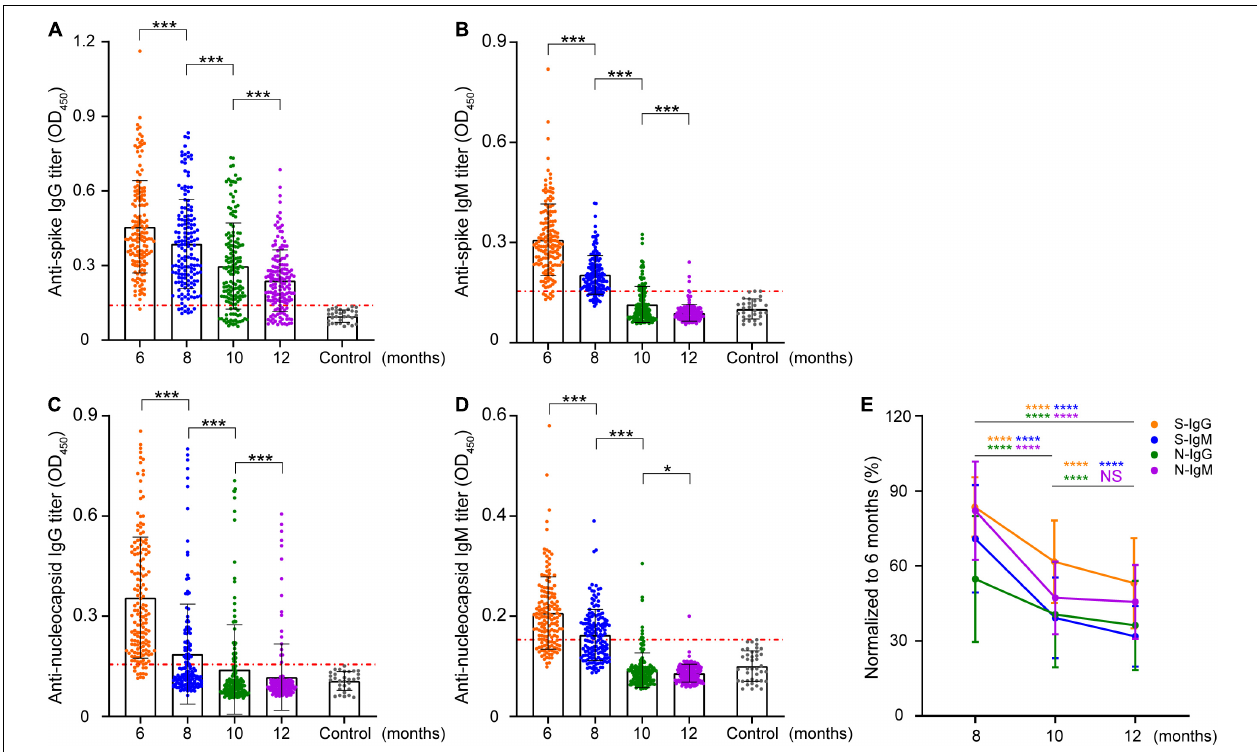
FIGURE 1 | Longitudinal analysis of IgG and IgM against SARS-CoV-2 S/N in patients. The intensity changes of different antibodies were longitudinally compared at a titer of 1:400. (A–D) Indicate the longitudinal changes in S-IgG, S-IgM, N-IgG, and N-IgM antibodies. Each data point represents a sample, the vertical line represents the median IQR, the red line marks the cutoff value of enzyme-linked immunosorbent assays (ELISA), and the y -axis represents the absorbance at 450 nm when the serum dilution is 1:400. (E) Normalization of the OD value of other time points with the OD value of antibodies in June. The y -axis represents the proportion of samples in August, October, and December to June for the same patient. The data are shown as the mean ± SEM. The significance is expressed as ns, P > 0.05; * P < 0.05; *** P < 0.001; **** P <